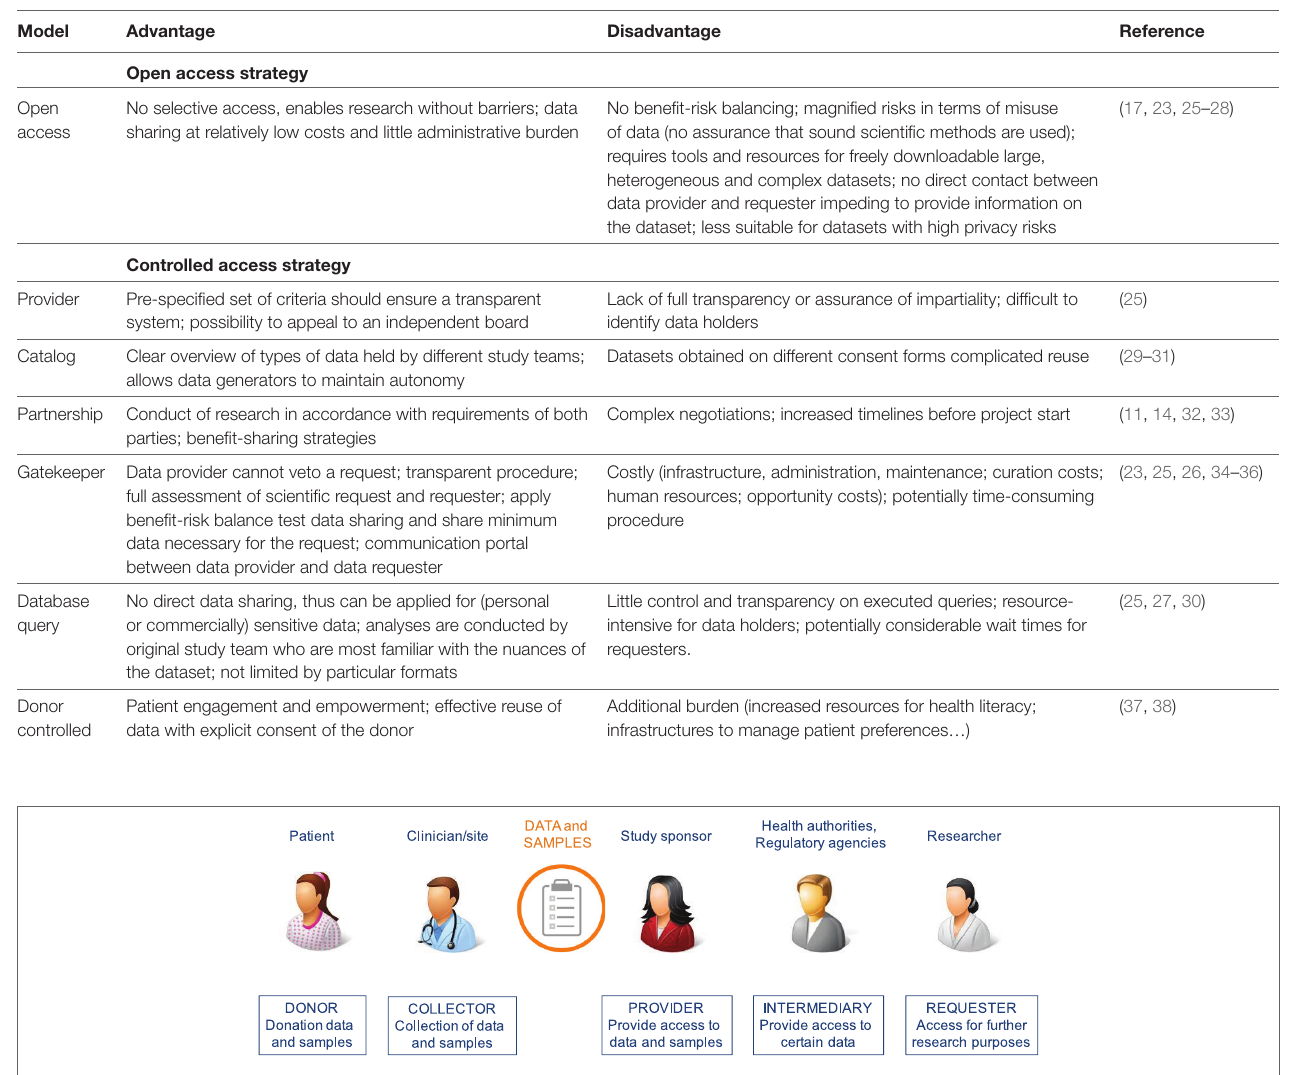
Table 1 | Examples of different data sharing models with respective benefits and